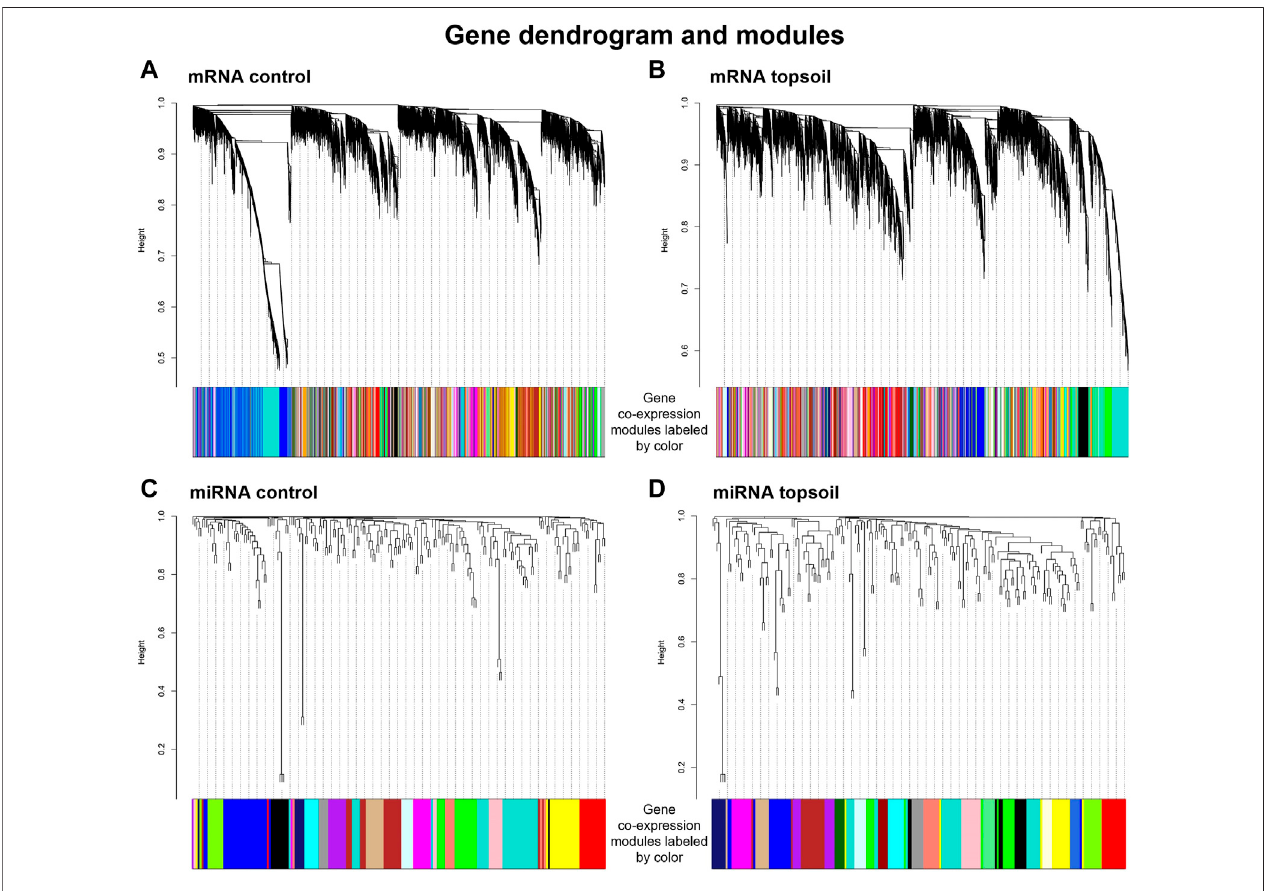
FIGURE 3| Geneco-expressionmodulesidenti fi edforthemRNAcontrolgroup (A) ,mRNAtopsoil (B) miRNAcontrol (C) andmiRNAtopsoil (D) groups.Co-expression modules are differentiated by color. Each group of co-expression modules is accompanied with the corresponding gene dendrogram.